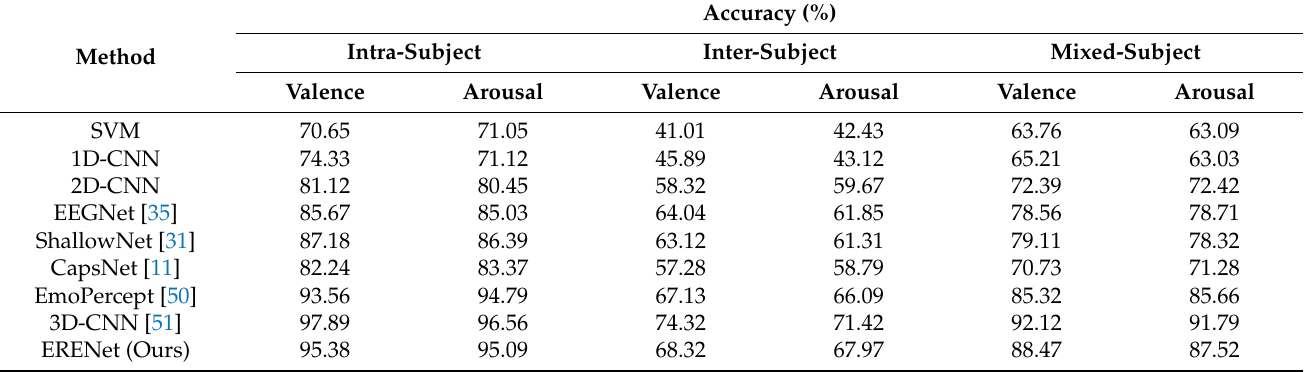
Table 7. The average accuracies of each method in intra-subject, inter-subject, and mixed-subject classification